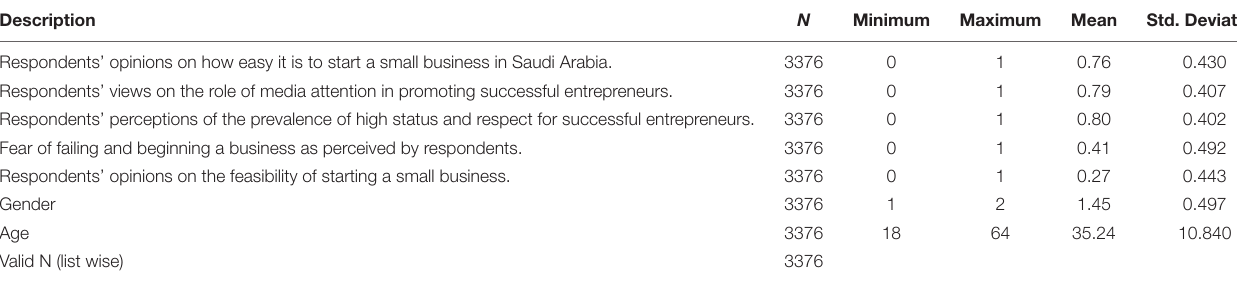
TABLE 2 | Descriptive statistics of study